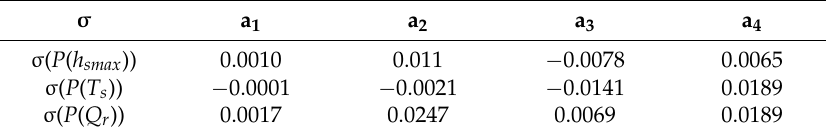
Figure 7. The Log-normal distribution’s parameter σ is modeled as a function of the exceedance probability of the wind induced surge h smax .